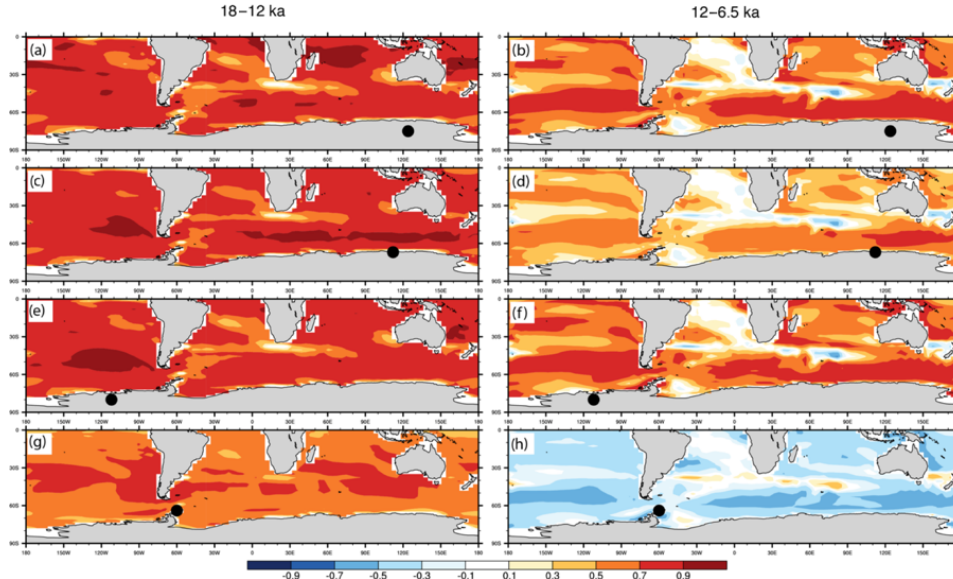
Figure 13. Spatial Pearson linear cross-correlation coefficients ( r ) between decadal SST and precipitation of the TraCE-21ka for (a, c, e, g) 18–12ka and (b, d, f, h) 12–6.5ka at the (a, b) EDC (73–77 ◦ S, 121–127 ◦ E), (c, d) LD (65–70 ◦ S, 110–116 ◦ E), (e, f) WDC (77–82 ◦ S, 115–109 ◦ W), and (g, h) JRI (63–65 ◦ S, 59–62 ◦ W) ice core